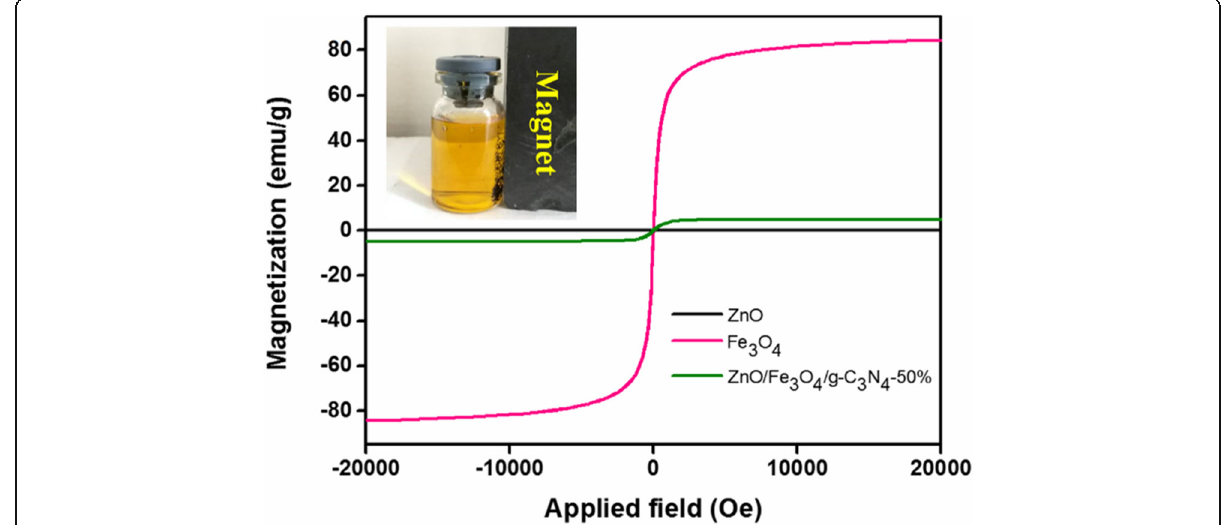
Fig. 8 Magnetic hysteresis curves of ZnO, and ZnO/Fe 3 O 4 /g-C 3 N 4 -50% spectra at room